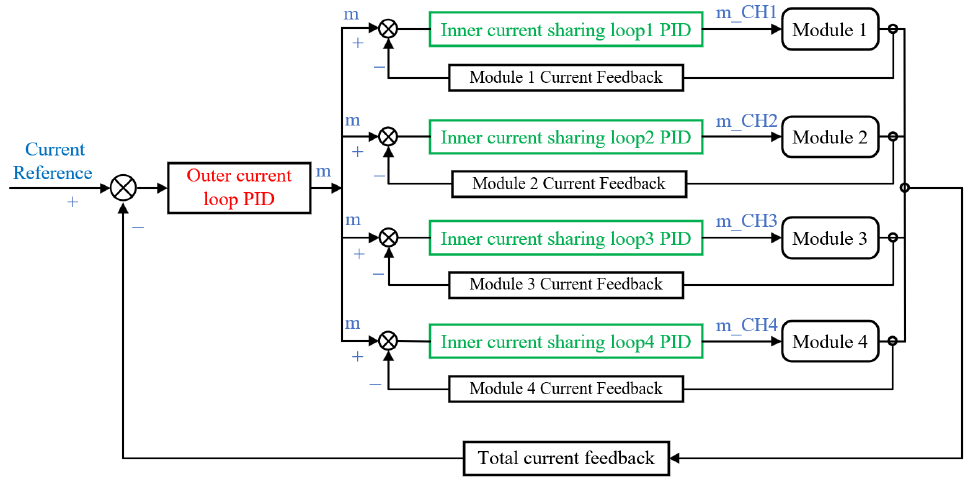
Figure 4. Block diagram of current